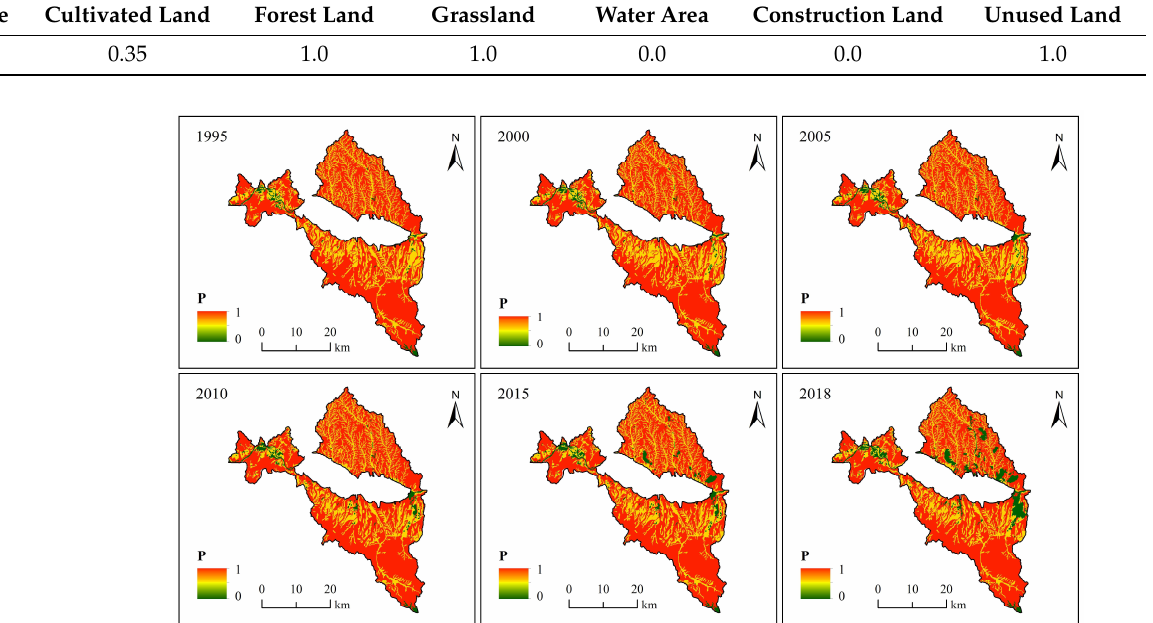
Table 1. p values of different land-use types in the South and North Mountains of Lanzhou.